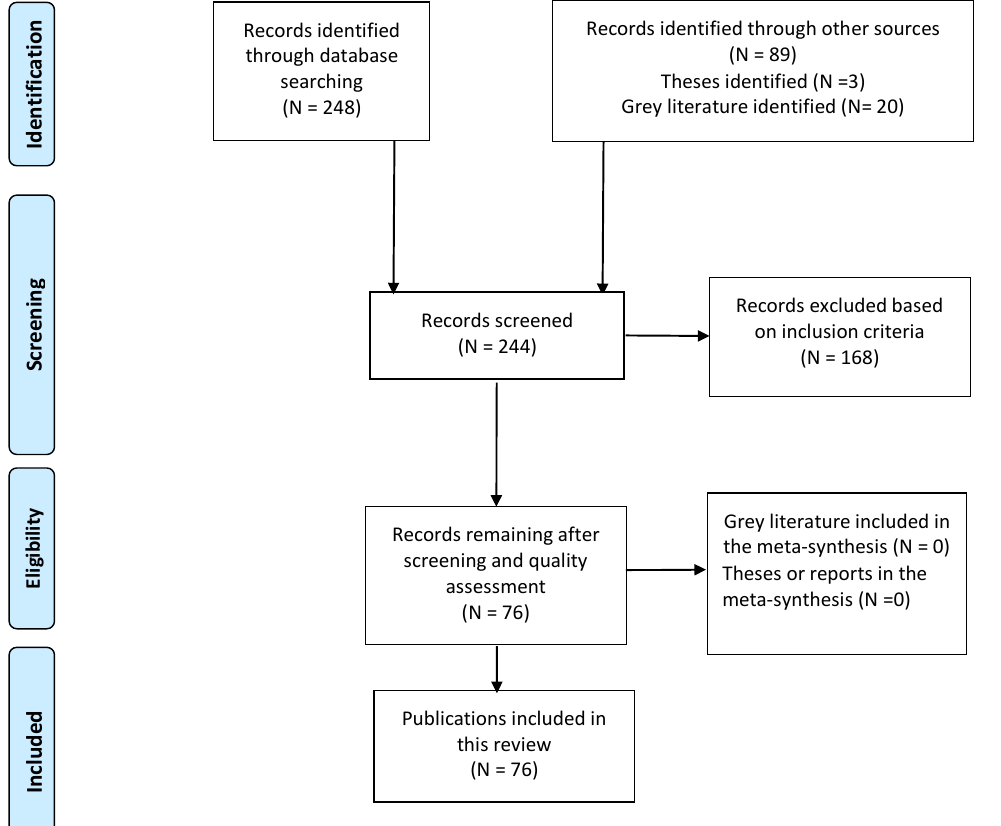
Figure 1. Flow chart showing meta-synthesis review process.